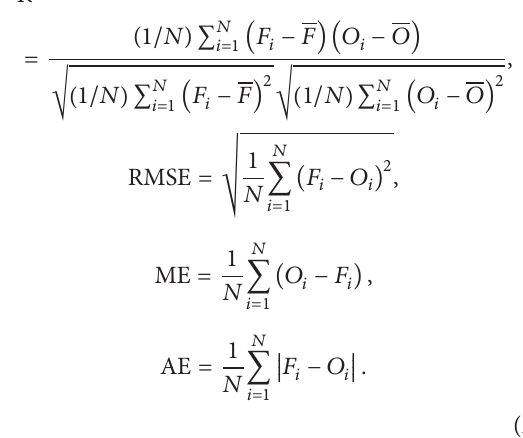
were used to evaluate the impact of the DA experiments in this study. They are defined